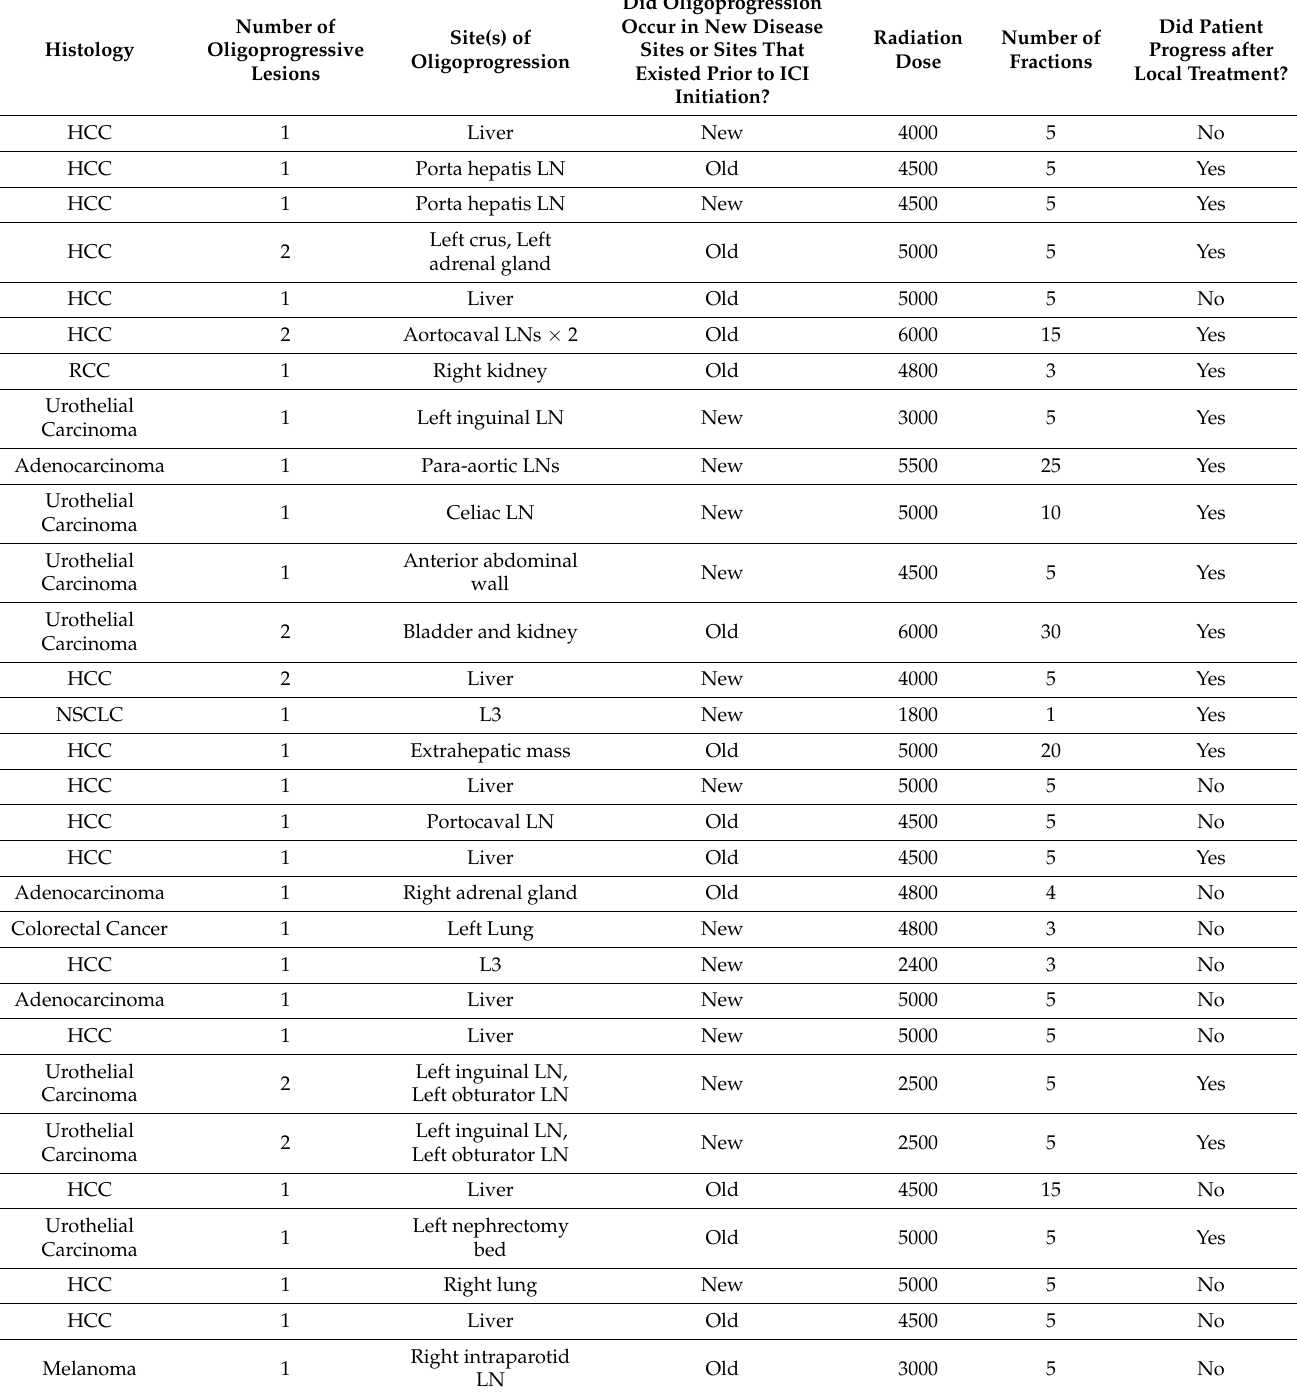
Table 2. List of oligoprogressive